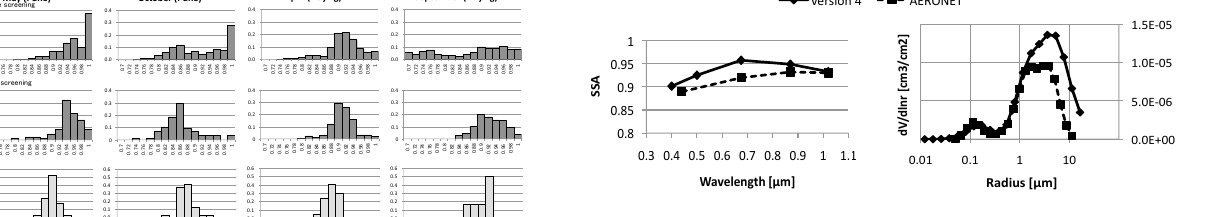
Fig. 17. SSA (left panel) and SDF (right panel) retrieved by SKYNET (solid lines) and AERONET (broken lines) on 11 May 2008, 10:27:00UTC.